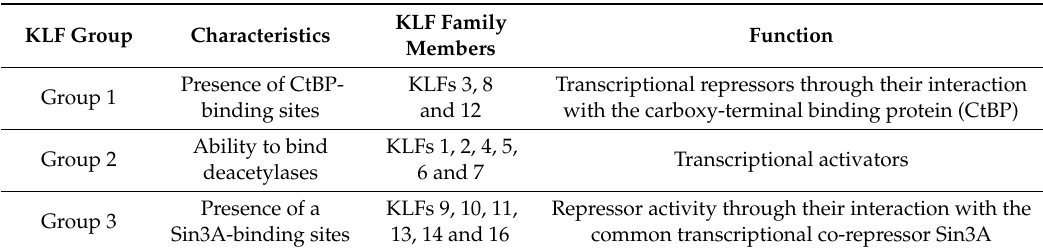
Table 1. Kruppel-like factor (KLF) family